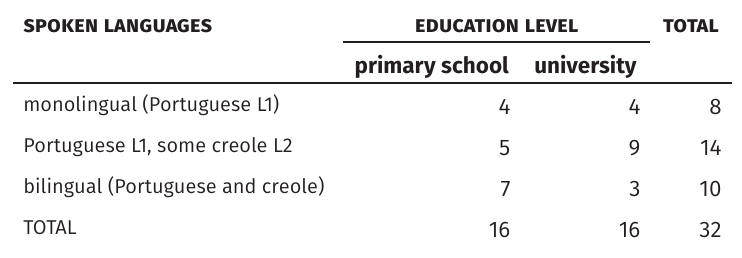
Table 12: Cross tabulation between SPOKEN LANGUAGES and EDUCATION LEVEL: number of